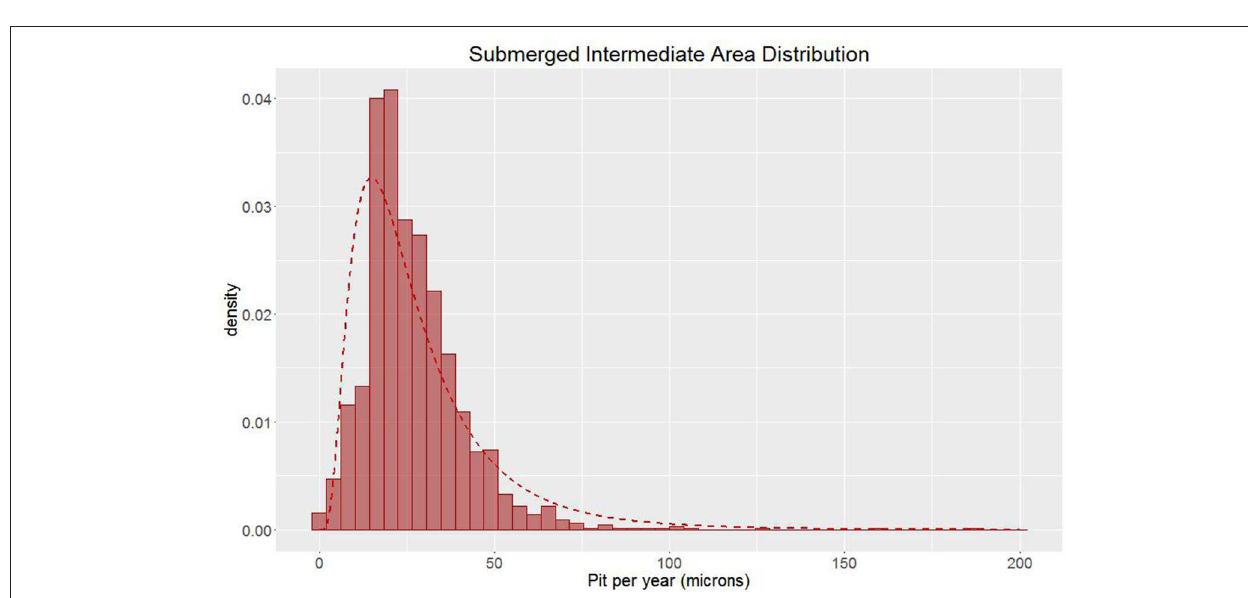
FIGURE 7 | Corrosion depth distribution at submerged intermediate area (section